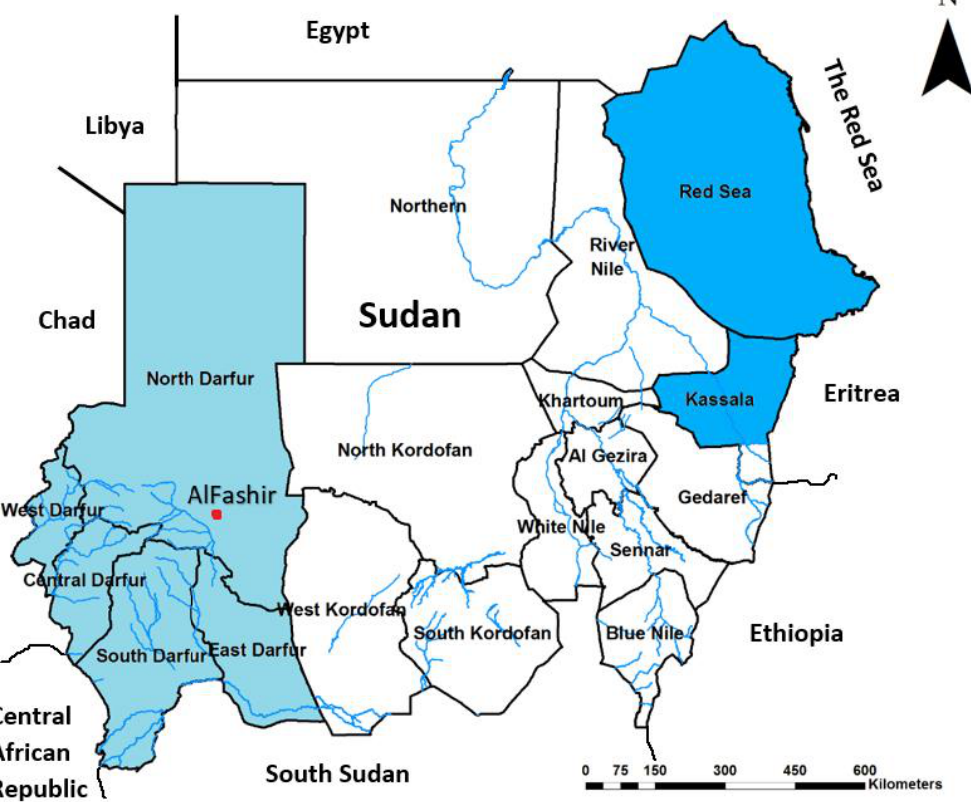
Figure 1. Map of Sudan showing the study area of Greater Darfur (in the light blue color, and dengue fever endemic areas in Sudan (the darker blue).